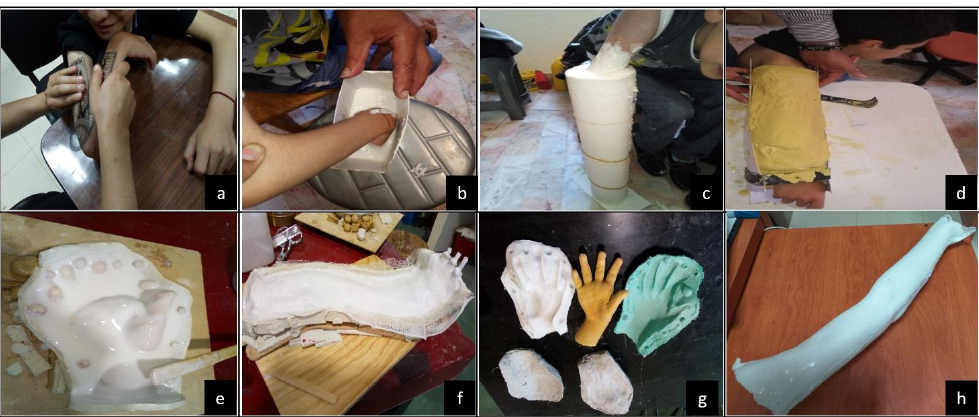
Figure 7. Patient’s upper limb characterization ( a ) ROM assessment. To obtain the casting molds, two styrene containers for arm-forearm and hand shapes were built with every segment of the patient extended to obtain the largest possible dimensions ( b – d ). Then, alginate (BioJel TM ) was used for each casting mold. The casting molds were divided into positive and negative parts ( e , f ). Silicon (Polysil P-48 TM ) was used to obtain two dummy products for 3D digitalization ( g , h ). When the molds were casted, extra load was added to reach the desired positions.